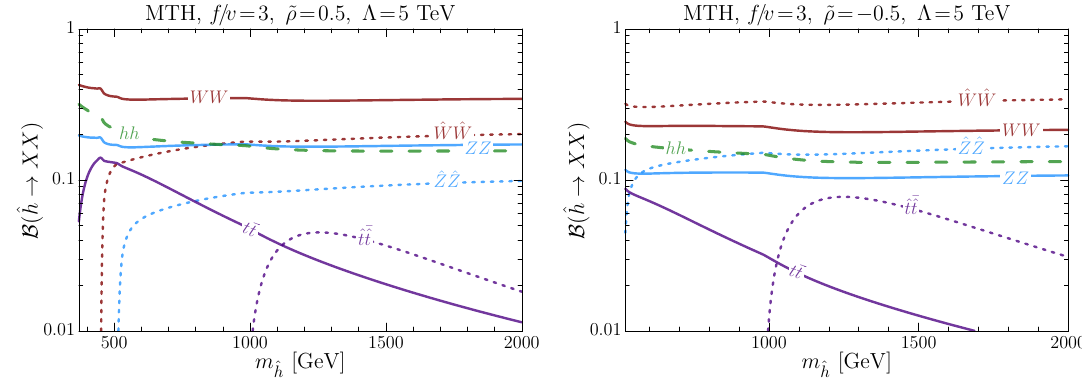
Figure 4 . Same as (cid:12)gure 3 but for explicit hard breaking parameter ~ (cid:26) = 0 : 5 (left) and (cid:0) 0 : 5 (right). a consequence, the LHC (and/or future colliders) would be able to probe more region of TH parameter space with ~ (cid:26) > 0 than for ~ (cid:26) < 0 (see below). In (cid:12)gure 5 we show parameter space of the MTH model in m (cid:0) f=v plane with ^ h f contours of heavy twin Higgs cross-sections to a pair of SM vector bosons i.e. (cid:27) gg (cid:17) ^ h ! ZZ f (cid:27) ( gg ! ^ h ) (cid:1) B (^ h ! ZZ ) (solid blue curves), and SM Higgs signal-strength (cid:22) gg (dashed h ! ZZ red curves). The cross-section is calculated at the LHC with the center-of-mass energy 14 TeV. The left and right plots in (cid:12)gure 5 are for hard breaking parameter ~ (cid:26) = 0 and ~ (cid:26) = 0 : 5, respectively. Similarly, (cid:12)gure 6 presents contours of heavy twin Higgs cross-section f to a pair of SM Higgs bosons, (cid:27) gg (cid:17) (cid:27) ( gg ! ^ h ) (cid:1) B (^ h ! hh ) (solid green curves). The ^ h ! hh description of shaded regions in (cid:12)gures 5 and 6 are as follows: (cid:15) Gray region of (cid:12)gures 5 and 6 represents unphysical parameter space excluded by the theoretical constraints as outlined in the previous section. (cid:15) Orange area ((cid:12)gures 5 and 6) captures parameter spaces where heavy twin Higgs width is greater than its mass, (cid:0) > m . ^ h ^ h f and CMS analysis of the SM Higgs signal-strength ( (cid:22) gg < 0 : 79) at the LHC [51]. h ! ZZ